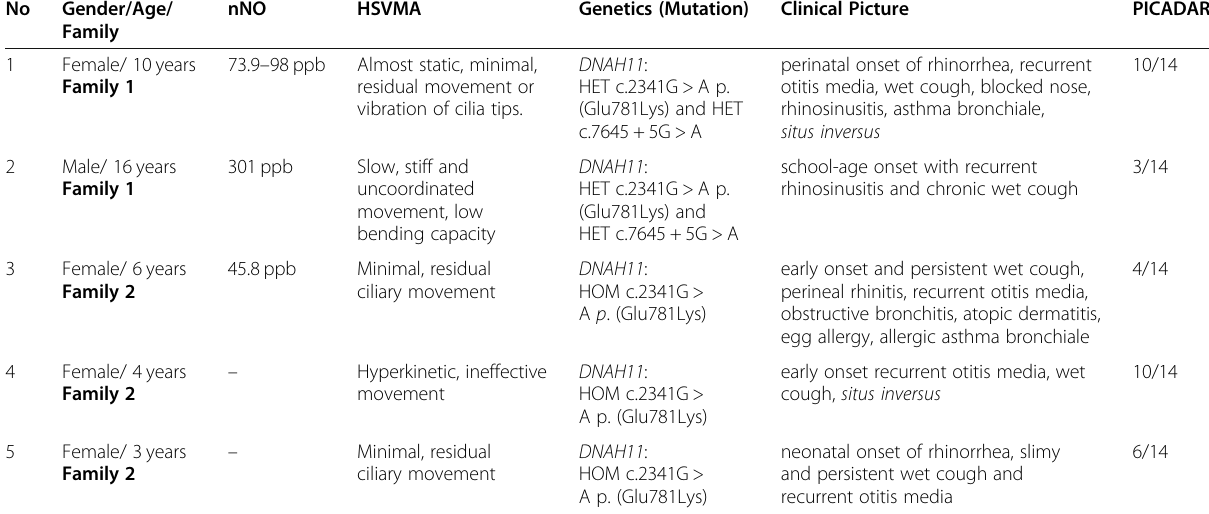
Table 1 Patient